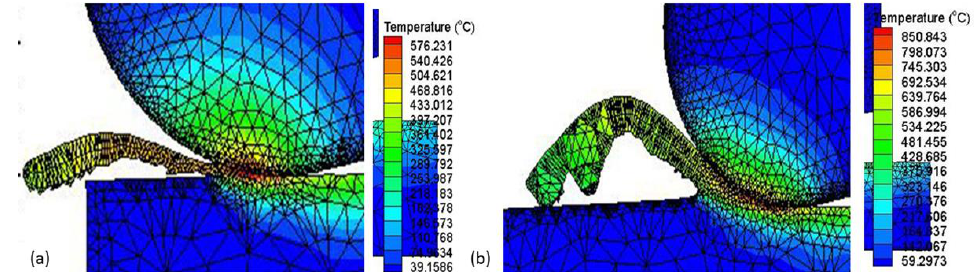
Figure 8. The simulated temperature distributions on the rake face: ( a ) Experiment 1; ( b ). Experi- ment